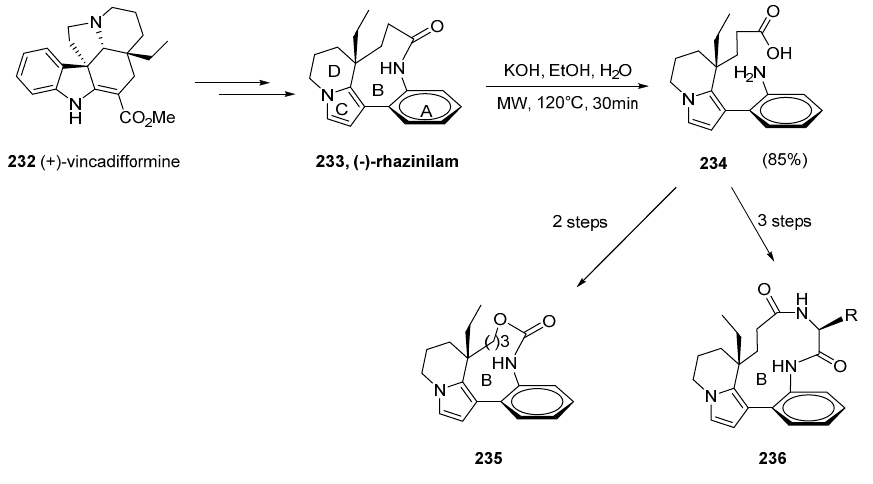
Scheme 49. MW-assisted synthesis of ( − )-rhazinilam